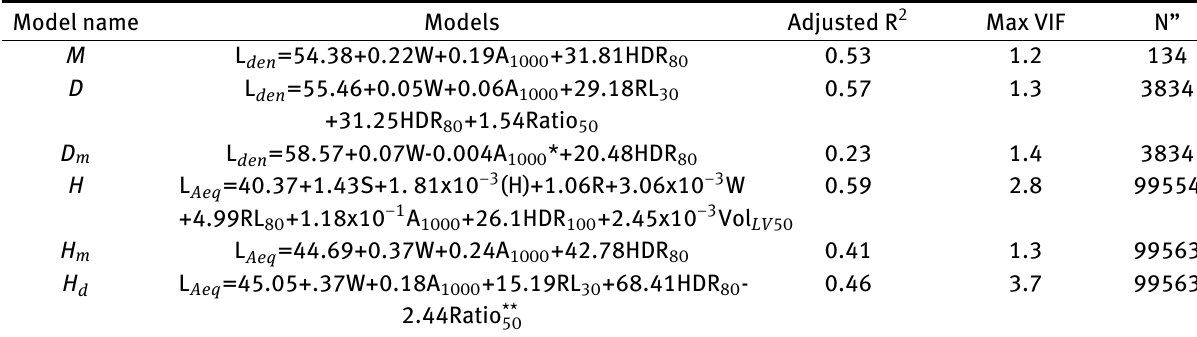
Table 3: List of developed models (Variables statistically significant at <